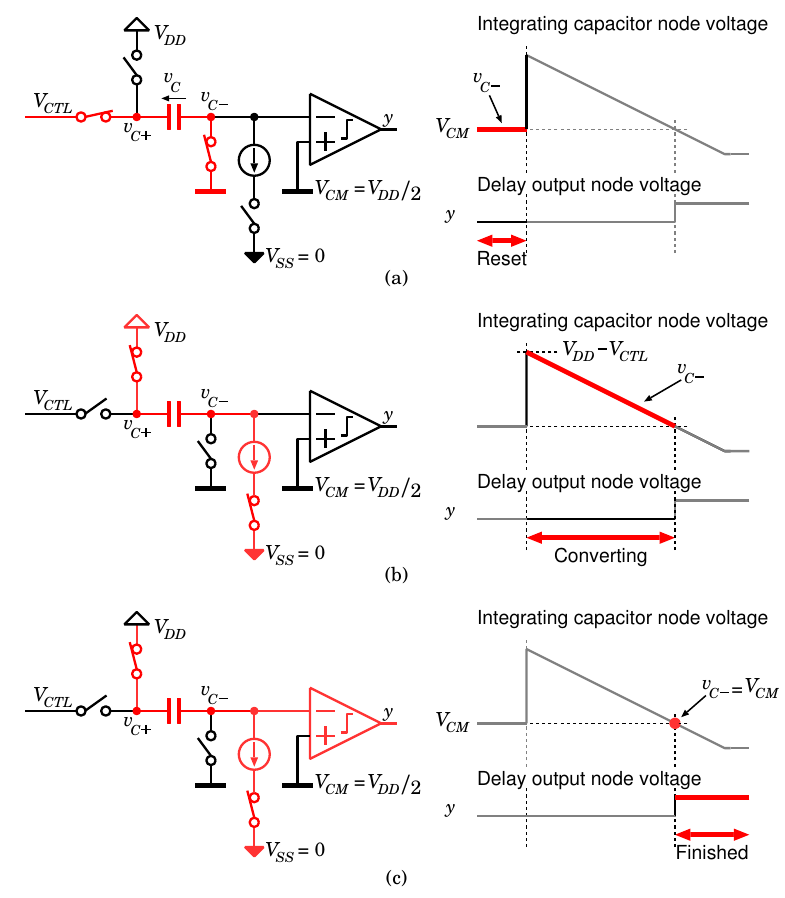
Figure 11. Timing diagram of VTC, ( a ) reset state, ( b ) integration state, and ( c ) conversion completed. The jitter requirement for VTC can be derived by substituting T LSB and σ TDC into Equation 4 as σ VTC ≤ 1.61